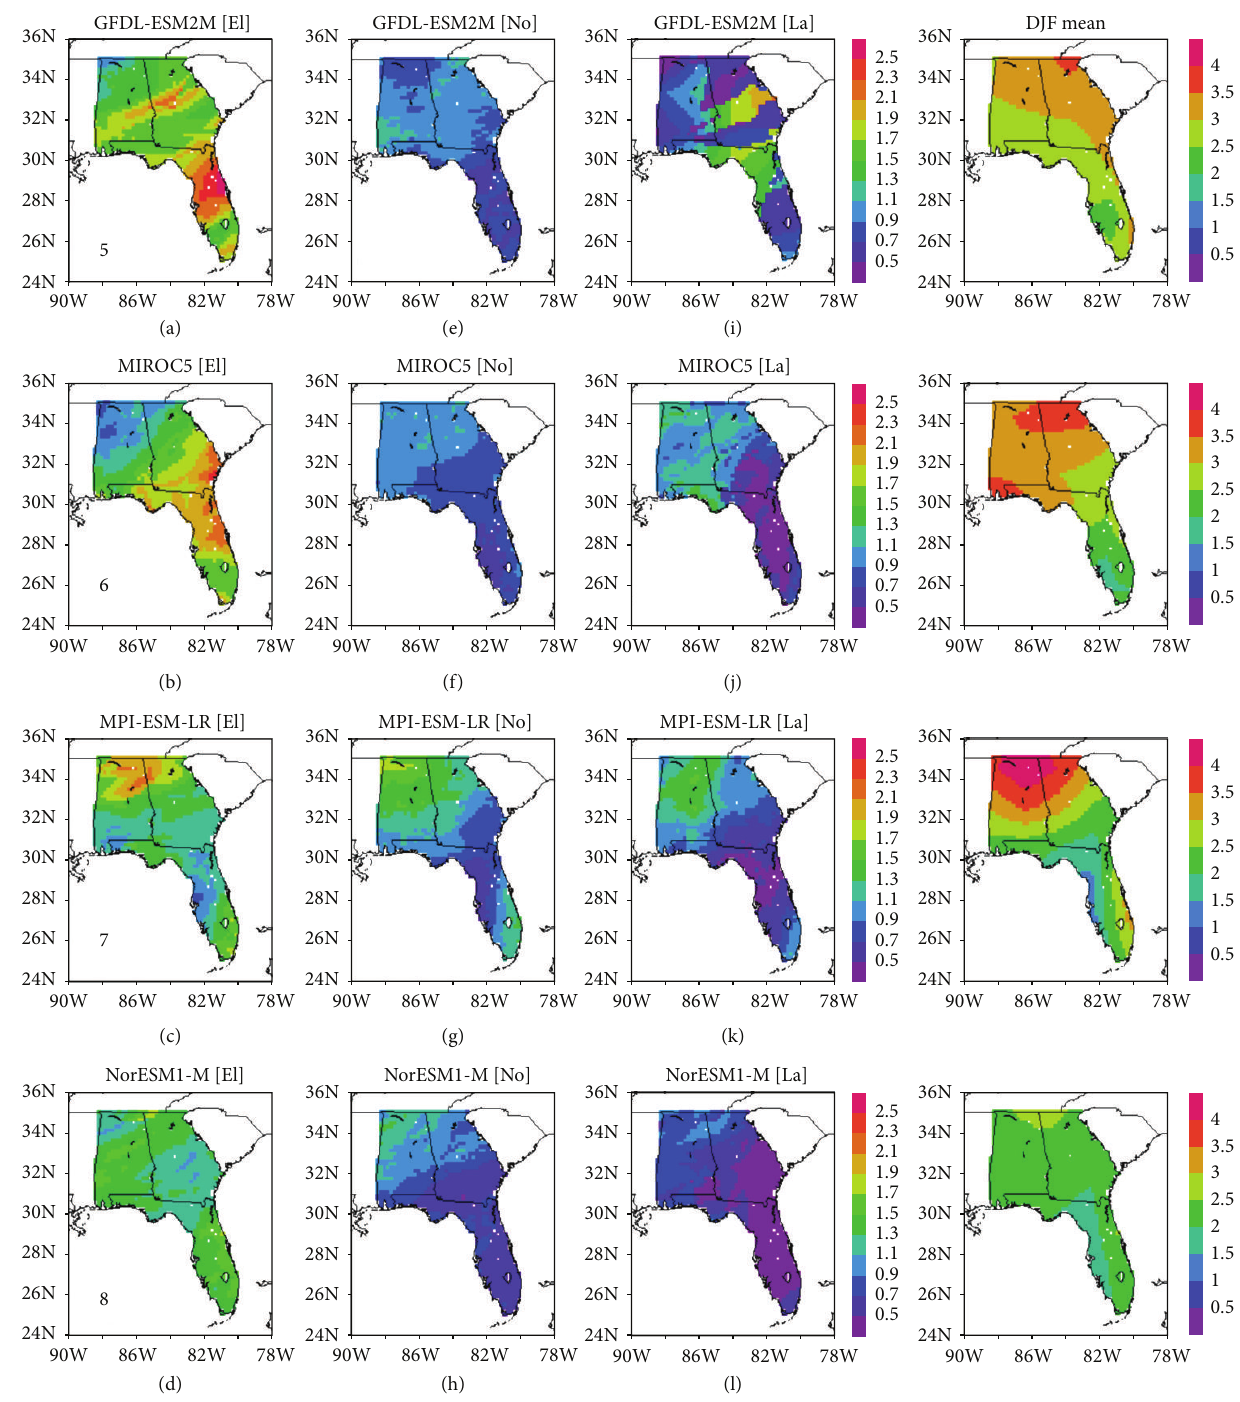
Figure 6: Same as Figure 5 but for CMIP5 models